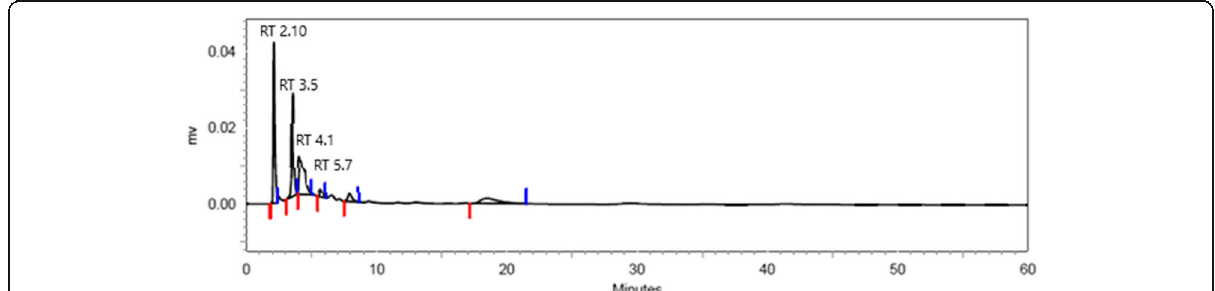
Fig. 6 HPLC analysis depicted that EPS contains 615 mg/ml, 22.1 mg/ml and 4.1 mg/ml of glucose, mannose and galactose respectively in purified